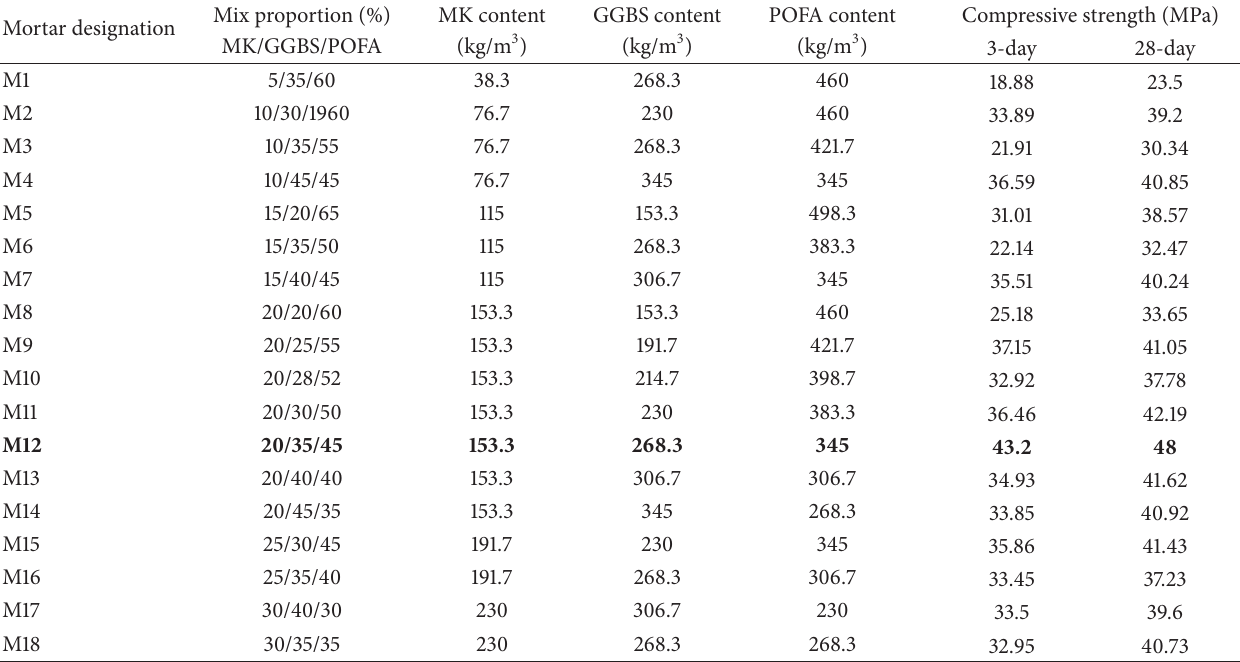
Table 3: Mix design for development of compressive strength of geopolymer mortar.